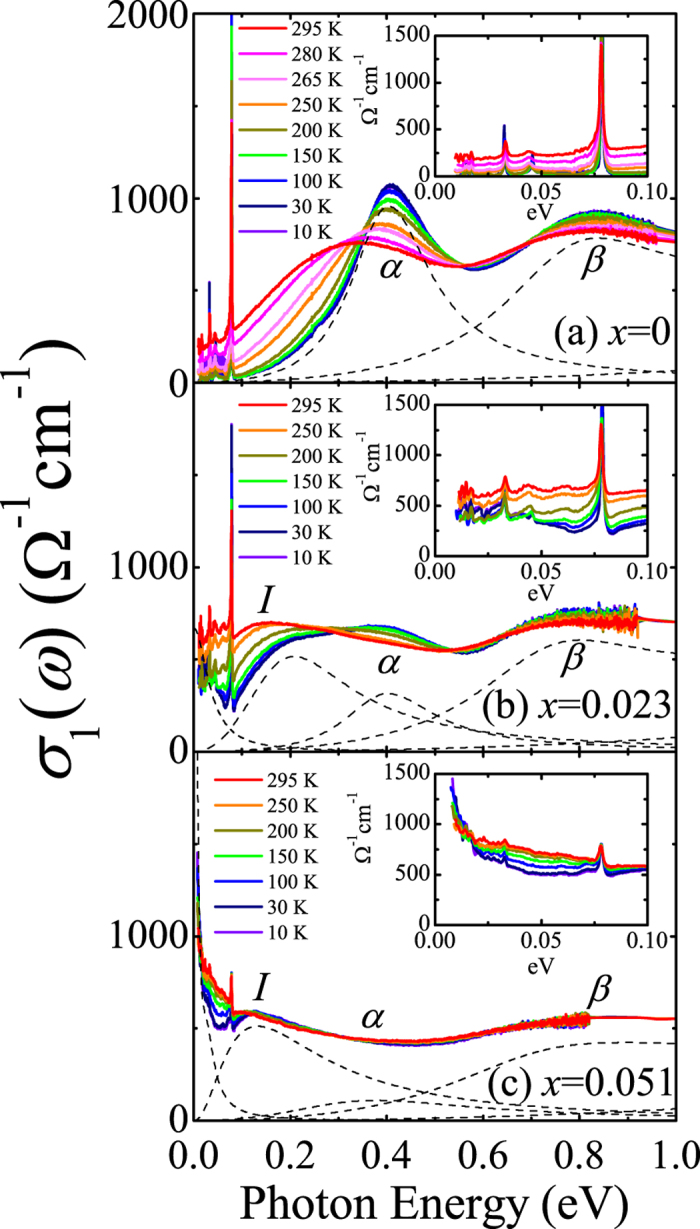
Real part of the optical conductivity spectra σ1(ω) of (a) Sr3Ir2O7 (x = 0), (b) (Sr0.977La0.023)3Ir2O7 (x = 0.023), and (c) (Sr0.949La0.051)3Ir2O7 (x = 0.051). Dashed lines represent the oscillators used to fit σ1(ω) at 10 K. We note that the oscillator labeled as β is composed of two Lorentzians. Insets: σ1(ω) below 0.1 eV.